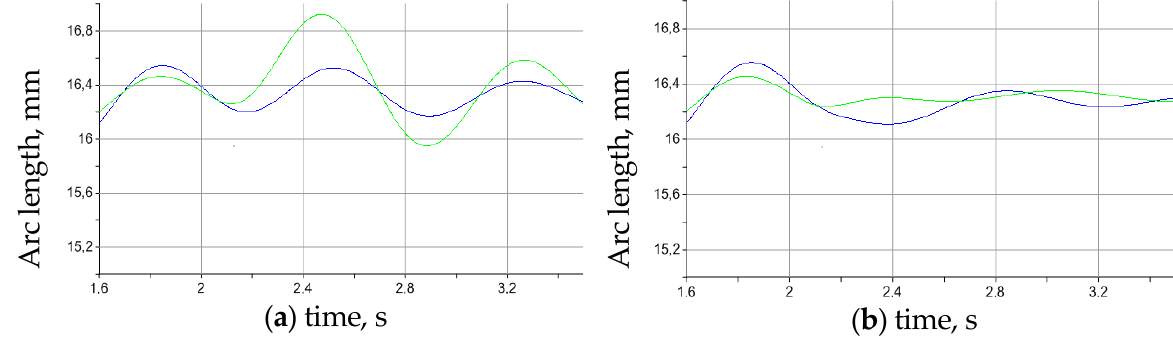
Figure 13. Arc length in phases B, C when perturbating the arc length in phase A, incases ( a )— without choke control, ( b )—with choke control as a function of current: in phase B, in phase C.